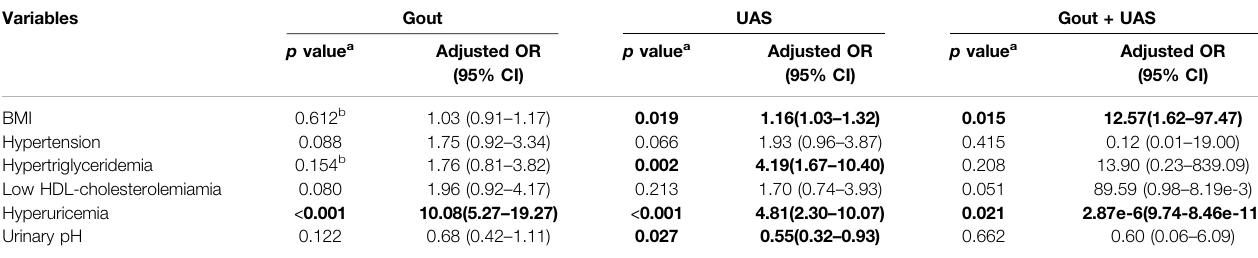
TABLE 3 | Multivariate logistic analysis of risk factors in each group studied.